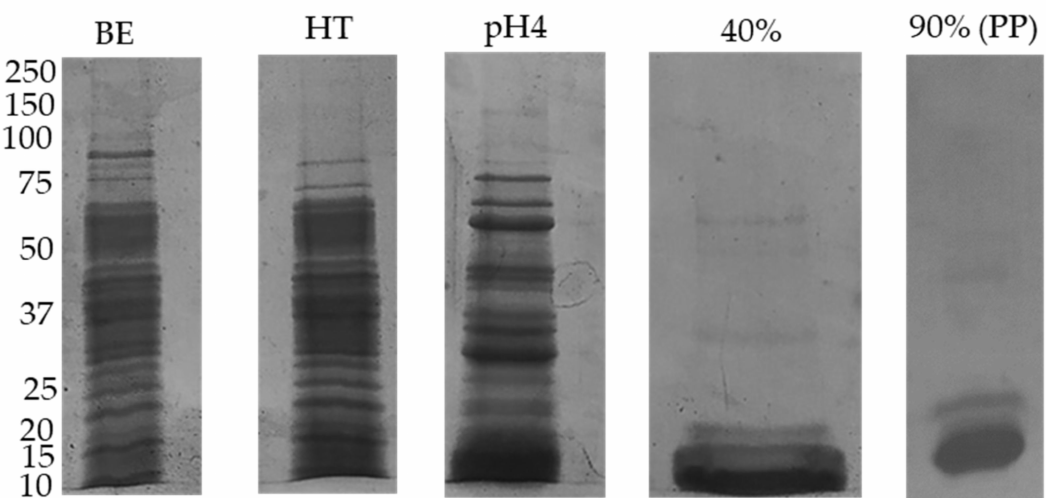
Figure 2. Representative images of the polypeptide profiles obtained after each step of the purification method as specified on the top of the gels. Each well was loaded with 25 µ g of protein extracts in a 17.5% ( w / v acrylamide) polyacrylamide slab gels. BE—Buffer Extraction; HT—Heat Treatment; pH4—Acid precipitation; 40%—40% v / v EtOH + 0.4M NaCl; 90% (Purified protein—PP)—deflamin obtained by 90% ( v / v ) EtOH.